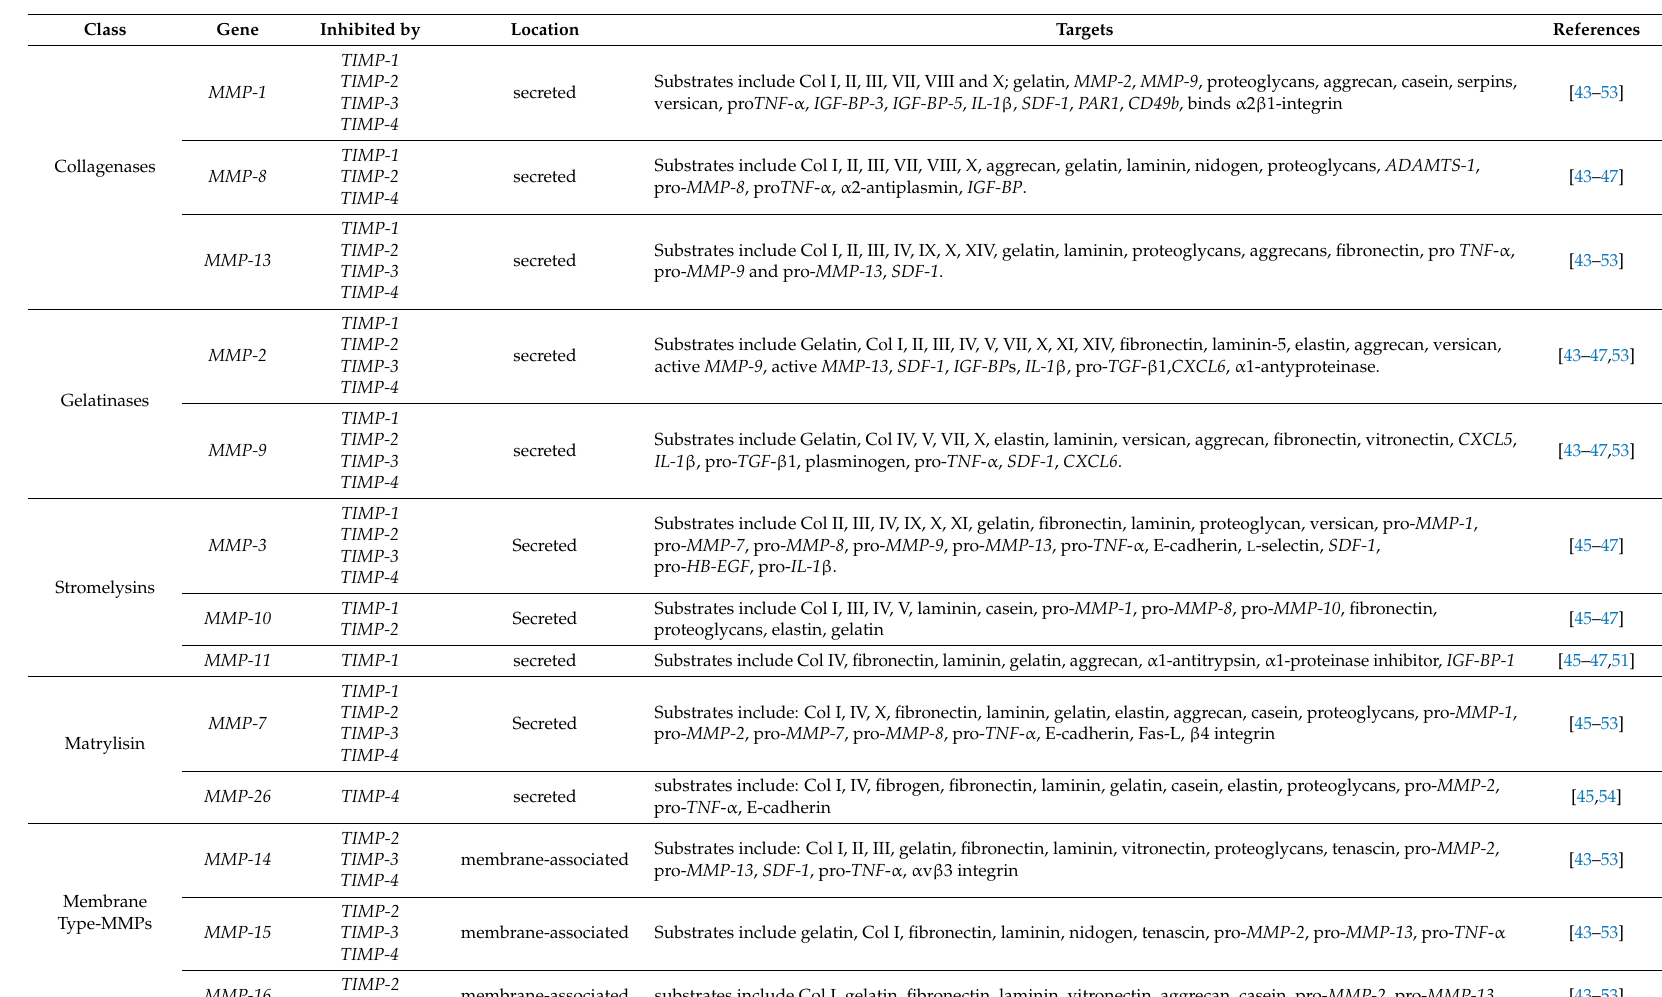
Table 1. Characteristics of metzincin family members known to be inhibited by